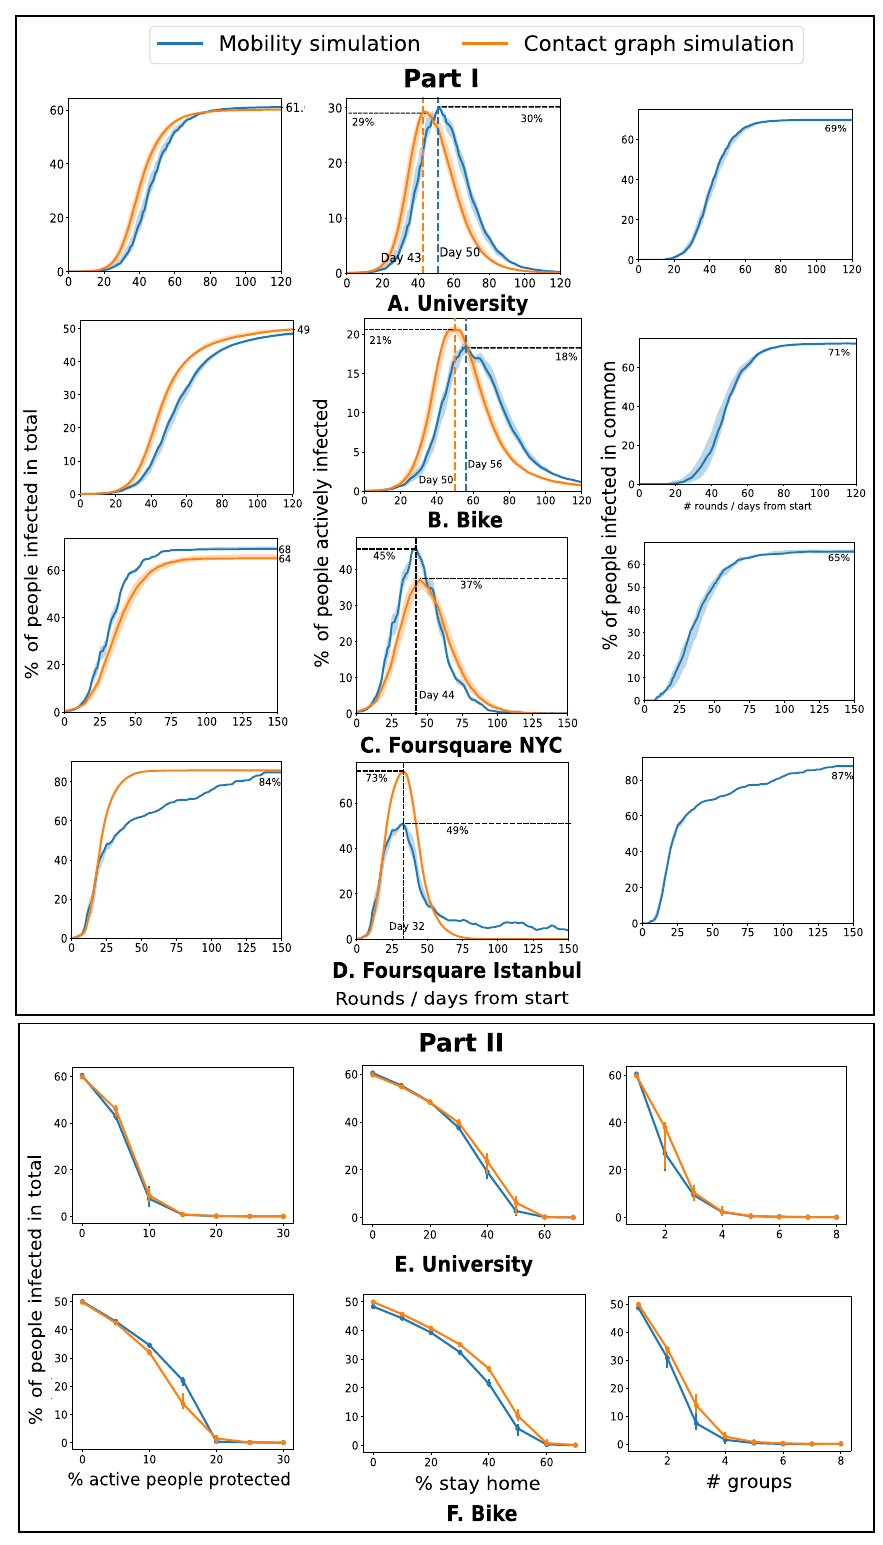
Figure 5. Contagion simulation in the derived social network model infects a similar number and similar set of agents as the simulation using mobility data in both with and without intervention settings. Part I: The curves for total infection numbers, actively infected agents, and Jaccard similarity of the infected agents match under no intervention scenario ( A – C ). Although in the Istanbul dataset ( D ), two infection number curves do not match after 25 days, similar sets of people get infected in the two simulations. Part II: In person to person infection spread model, with different intervention parameters, the final infection number is similar between the two models in all three intervention